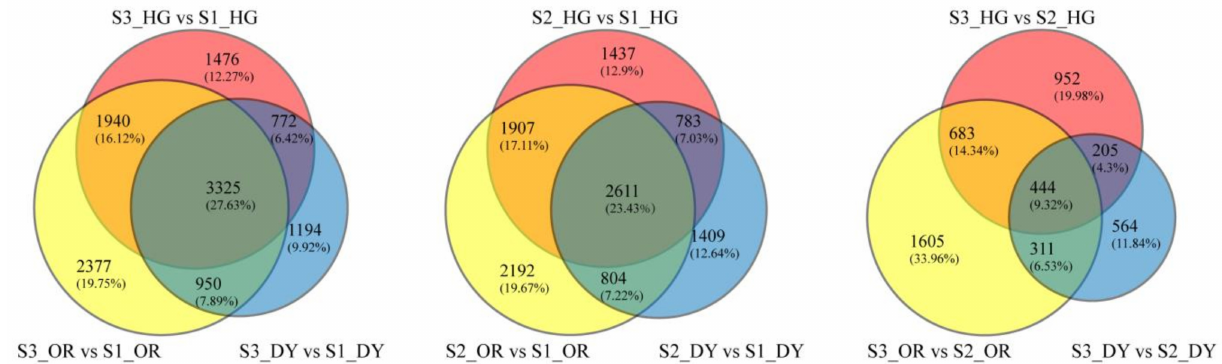
Figure 6. Venn diagrams of differentially expressed genes in the studied groups at different develop- mental stages of each cultivar. The number outside the parentheses is the number of genes contained in each region. The percentage of each region’s area to the total area is in